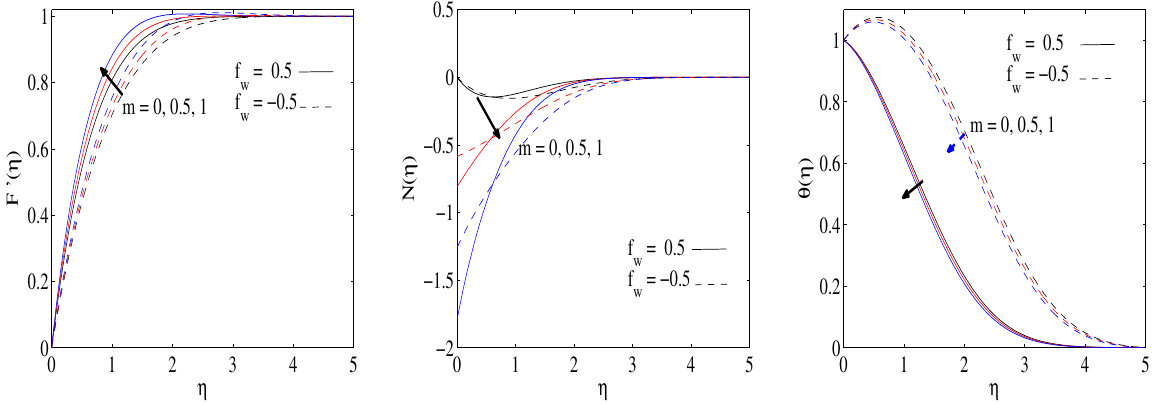
Figure 6. Velocity and angular velocity distribution under the impact of m